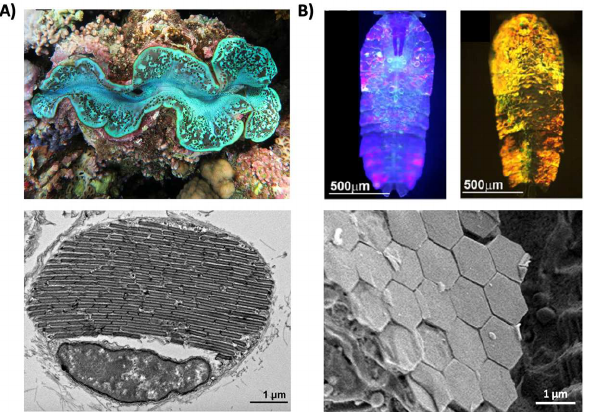
Figure 2. Structural color derived from guanine crystals. ( A ) ( Top ) An image of a giant clam ( Tridacn- inae ). ( Bottom ) An electron microscopy image of a giant clam iridocyte cell stacked with alternating layers of guanine crystal plates and cytoplasm sheets. ( B ) ( Top ) Images of male Sapphirinid copepods. ( Bottom ) A cryo-scanning electron microscopy image of an S. metallina copepod, showing hexagonal guanine crystals within iridophores below a chitin procuticle. The images in part ( A ) are reproduced from [30]. The images in part ( B ) are reproduced from